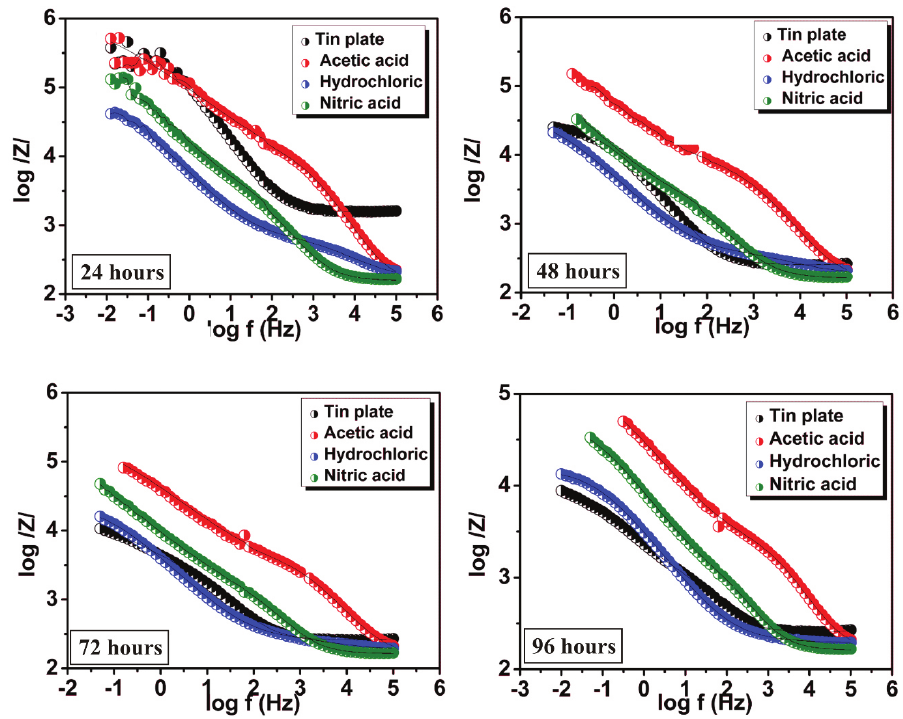
Figure 9. Bode 2 diagrams for different immersion time in a NaCl 0.05M solution.